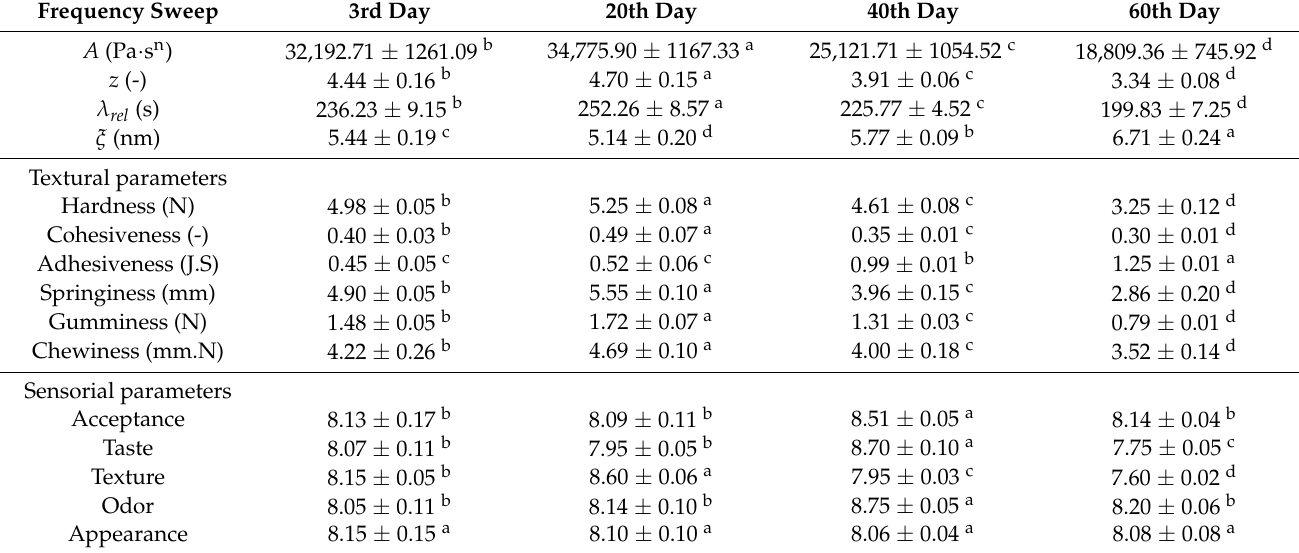
Table 7. The frequency sweep rheological parameters, textural and sensorial parameters of SBL- extract-added cheese samples at different storage